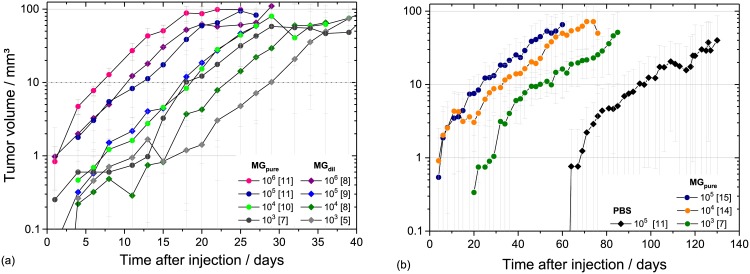
Tumour growth curves on mouse ear.Tumour growth curves obtained for (a) FaDu and (b) LN229 for the different cell/MG suspensions. The measured tumour volumes (see S1 Table for FaDu and S2 Table for LN229) in dependence on time were averaged for all animals of the corresponding group with the number of animals per group given in brackets. Grey dotted horizontal lines indicate the starting volumes of 5 mm3 and 10 mm3 for the exponential tumour growth of FaDu and LN229, respectively.